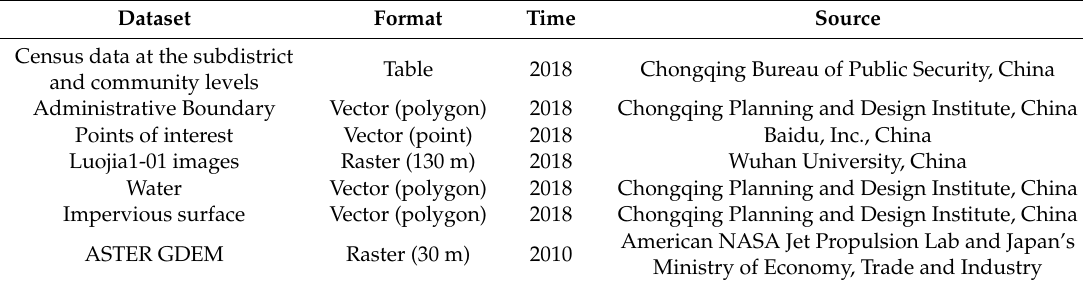
Table 2. List of the datasets used in this